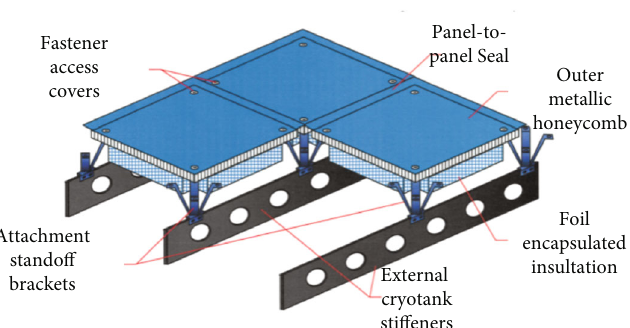
Figure 1: X-33 metallic